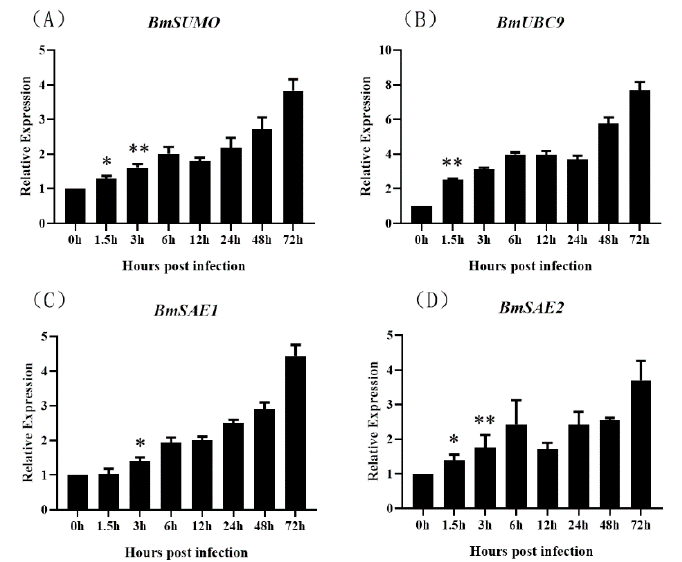
Figure 1. Expression of SUMOylation-related genes BmSUMO ( A ), BmUBC9 ( B ), BmSAE1 ( C ), and BmSAE2 ( D ) after BmNPV infection. BmN cells were infected with BmNPV (T3 strain) at a MOI of 10. At 0, 1.5, 3, 6, 12, 24, 48, and 72 hpi, the cells were collected and subjected to reverse-transcription quantitative polymerase chain reaction analysis. Statistical analysis was applied with SPSS software. One-way ANOVA with Tukey’s post-test was used. Significant differences are indicated by asterisks (* p < 0.05; ** p < 0.01).